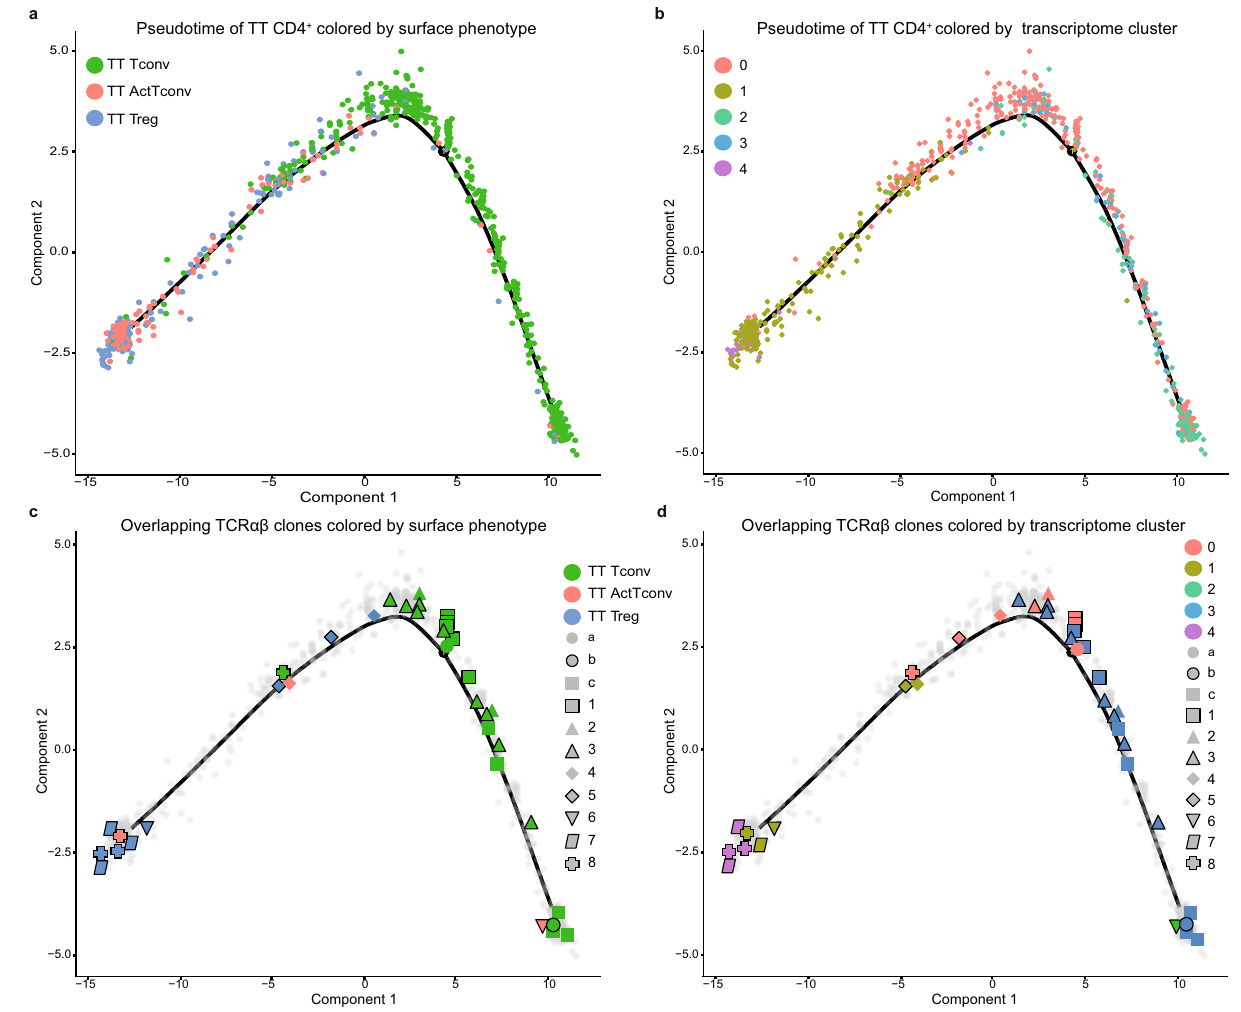
Fig. 5 Monocle single-cell trajectory of tumor-in fi ltrating CD4 + TC from breast cancer patients. Pseudotime transcriptome analysis of tumor tissue (TT)-derived CD4 + TC from four patients. a , b All TT CD4 + TC are depicted colored by ( a ) cell-surface phenotype (TT Tconv, green; TT ActTconv, red; TT Treg, blue) or ( b ) single-cell transcriptome cluster (0: red, 1: orange, 2: green, 3: blue, 4: purple). c , d All expanded (n ≥ 2 single cells) TCR αβ clones (unique paired TCR αβ nucleotide sequences) are depicted colored by ( c ) cell-surface phenotype (TT Tconv, green; TT ActTconv, red; TT Treg, blue) or ( d ) transcriptome cluster (0: red, 1: orange, 2: green, 3: blue, 4: purple) on a gray background of unexpanded clones ( n = 1 single-cell). Each particular shape corresponds to a different unique TCR αβ clone. TCR αβ clones a-c are shared between tumor-in fi ltrating Tconv and circulating MAMI-reactive IFN γ + Teff, while clones 1 – 8 are shared between different ( c ) cell-surface phenotypes or ( d ) clusters within the